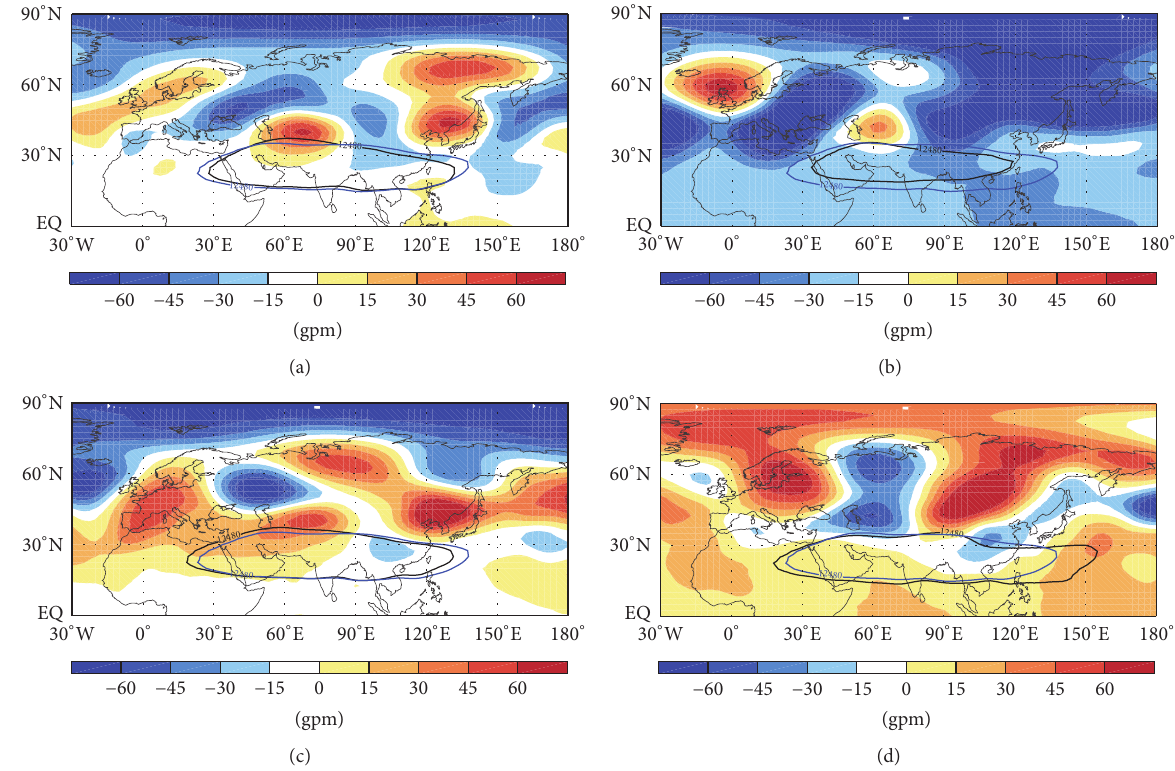
Figure 15: 200 hPa GPH anomalies (shading) (units: gpm) of the SFND pattern in the summers of (a) 1973, (b) 1976, (c) 1994, and (d) 2002; blue lines denote the climatology of 12480 gpm and black lines indicate 12480 gpm for the typical